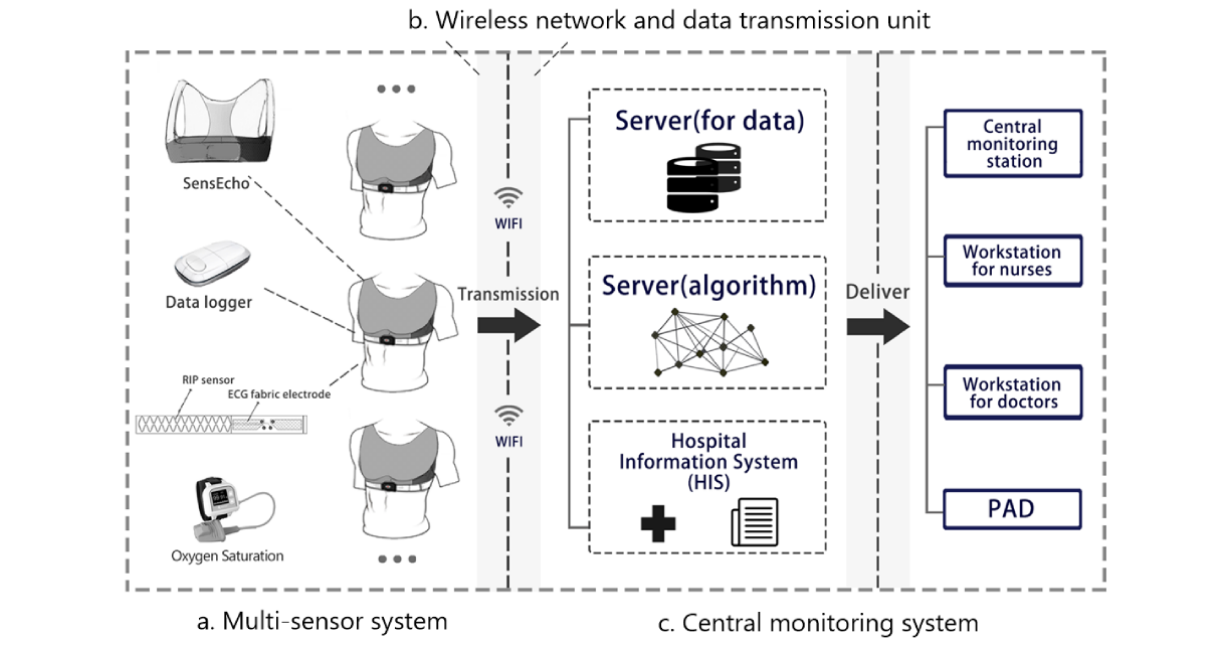
Figure 4. Overview of the SensEcho system.